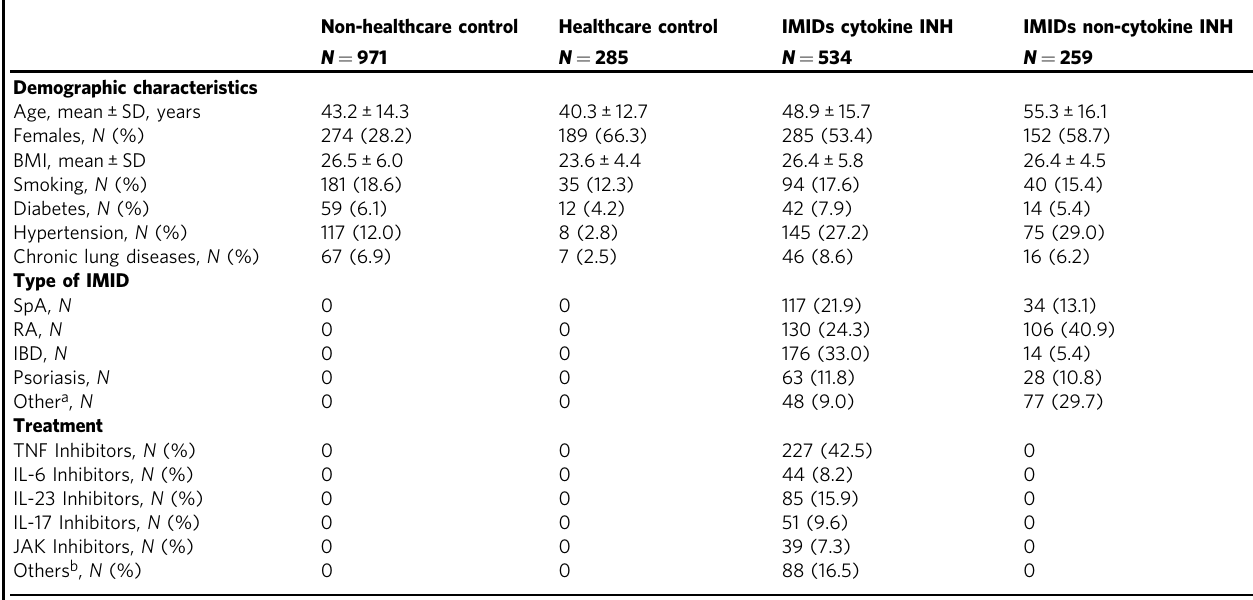
Table 1 Demographic and clinical